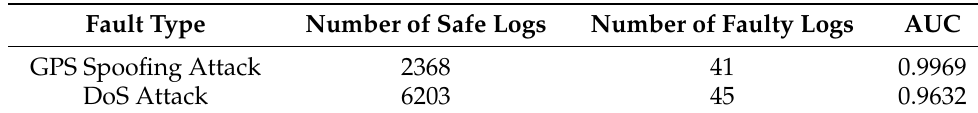
Table 3. Fault detection result on the flight without any recovery measures. Our approach achieved significant fault detection performances in both fault types.